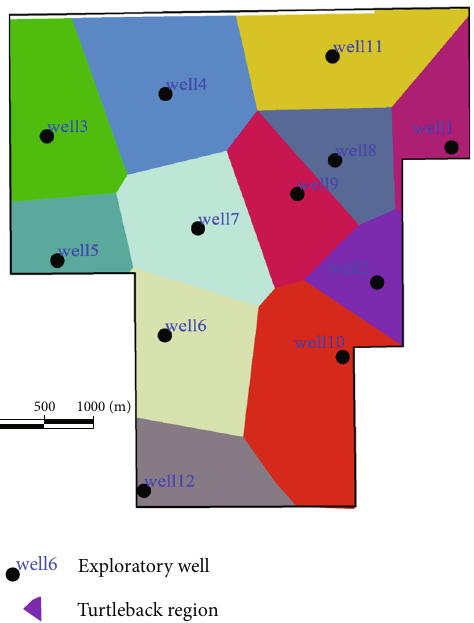
Figure 10: Isothermal adsorption curves of di ff erent regions with pH